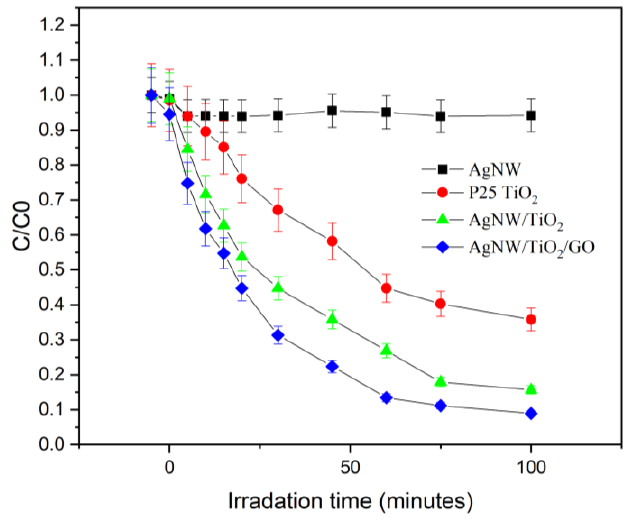
Figure 9. Photo-degradation of RhB for AgNW, P25 TiO 2 , AgNW/TiO 2 , and AgNW/TiO 2 /GO nanocomposite samples.